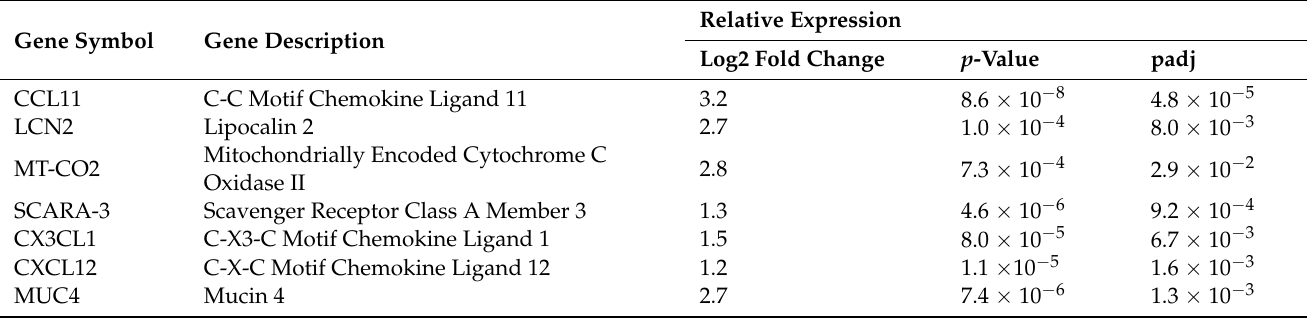
Table 3. Transbronchial biopsies with chronic rejection vs. acute rejection: crucial genes related to inflammatory and regulatory signatures.